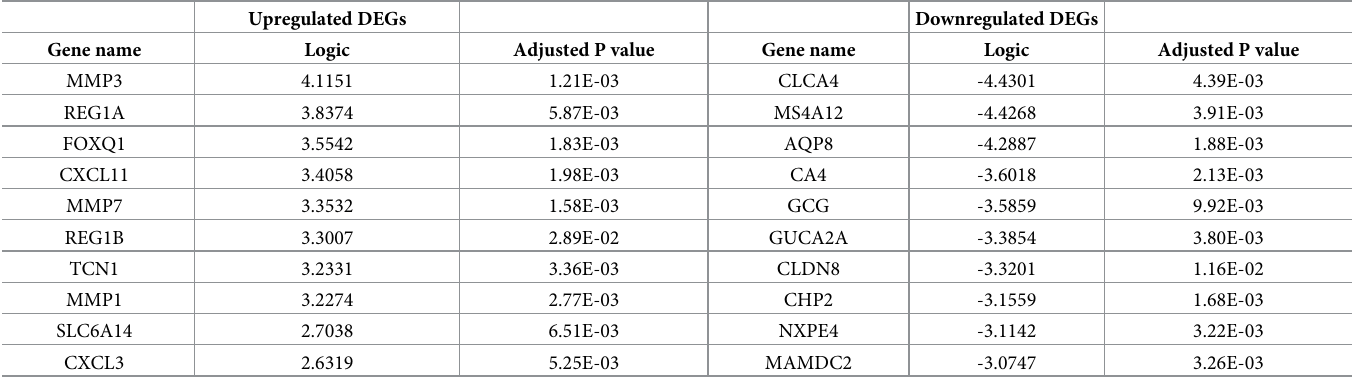
Table 1. The identified top 10 upregulated and downregulated DEGs between CRC tissue samples and normal tissue samples. Upregulated